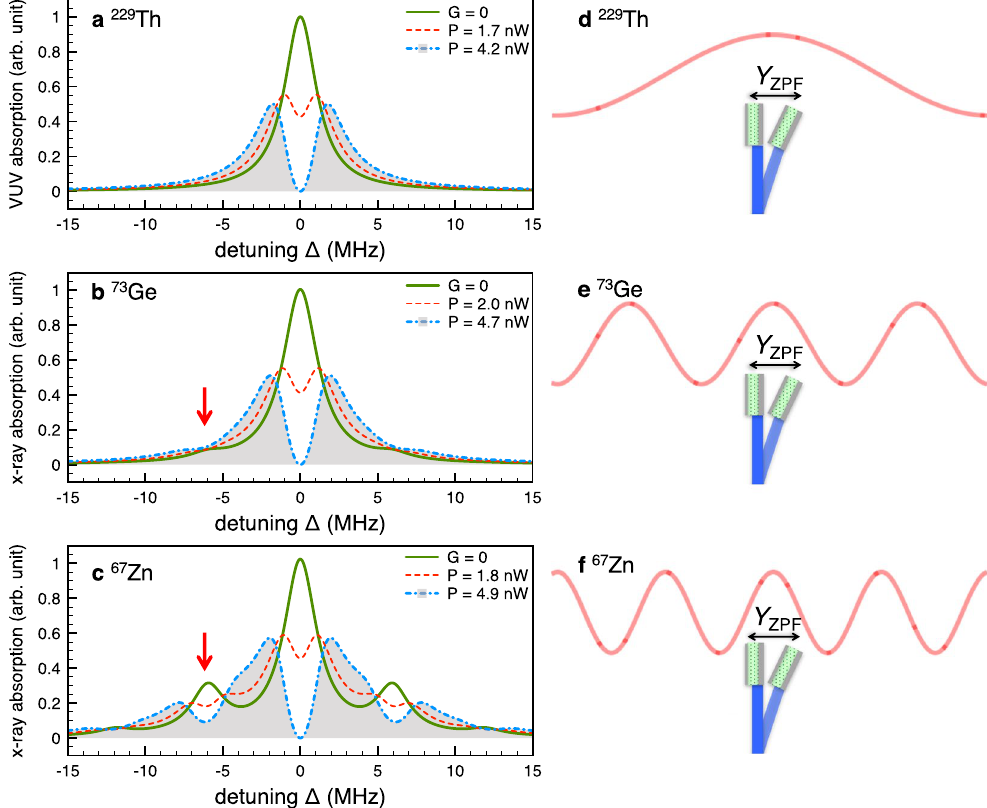
Figure 2. Optomechanically tunable x-ray/VUV absorption spectra and the corresponding ratio of the x-ray wavelength and the zero-point fluctuation Y ZPF . The microlever has an embedded layer with ( a ) 229 Th, ( b ) 73 Ge, ( c ) 67 Zn nuclei. Further parameters are taken from refs 1, 39 and the phonon number is chosen to be n = 5 × 10 6 . Green solid line illustrates the spectra in the absence of the optomechanical coupling. Red dashed (blue dashed-dotted) lines show the optomechanically modified spectra under the action of an optical laser with about P = 2 nW ( P = 5 nW). Red arrows indicate the first phonon lines. ( d – f ) Illustrations of the corresponding ratio of the x-ray wavelength and the zero-point fluctuation Y ZPF which determine the value of the Lamb-Dicke parameter.